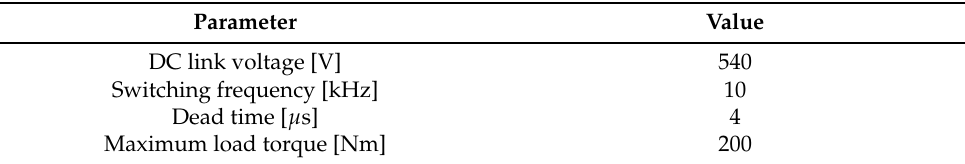
Table 3. Experimental setup